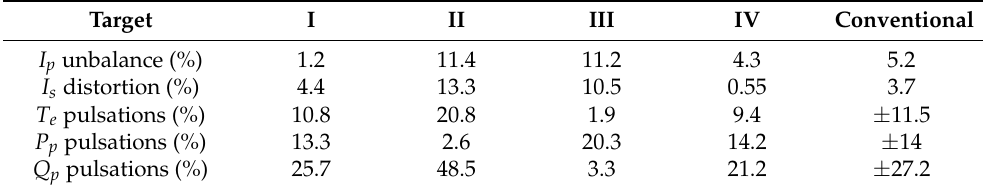
Table 1. Comparisons of different control targets with conventional control.